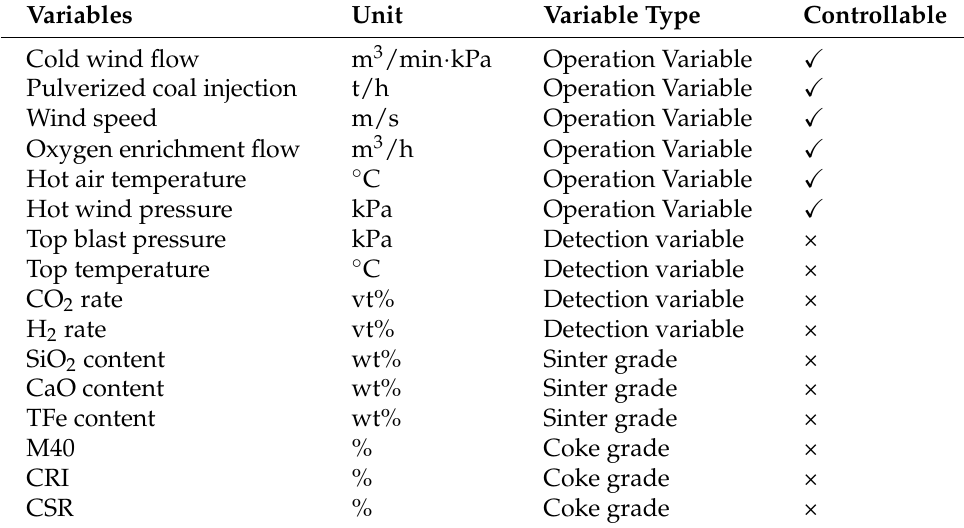
Table 1. Related